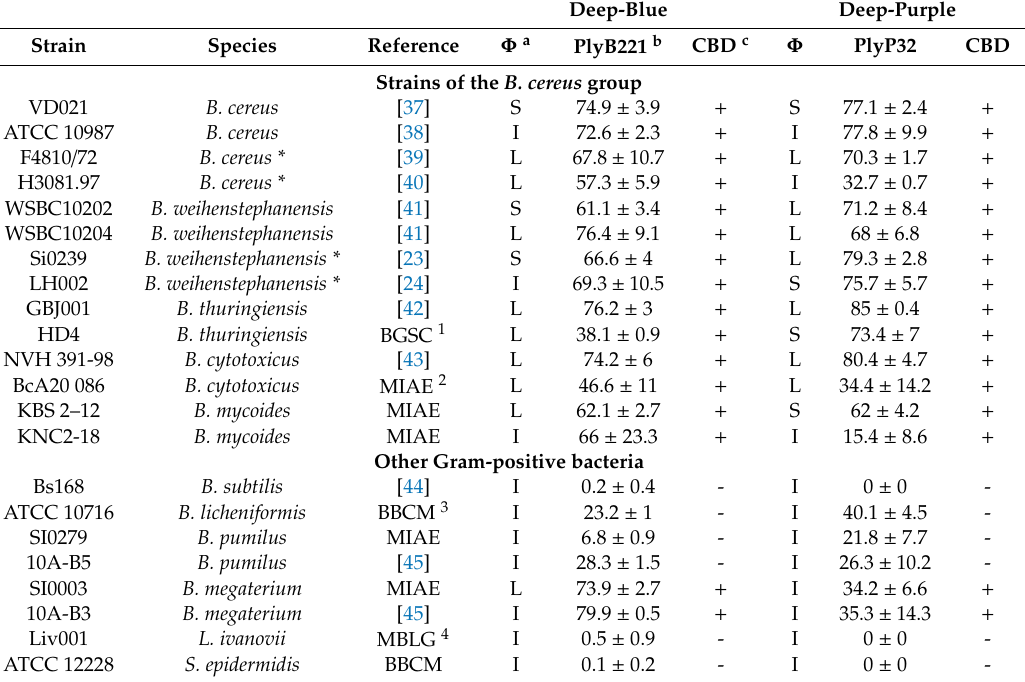
Table 3. Activity and binding spectra of PlyB221 and PlyP32 endolysins and their respective cell wall binding domain (CBD) compared to Deep-Blue and Deep-Purple phages host spectra. Phage